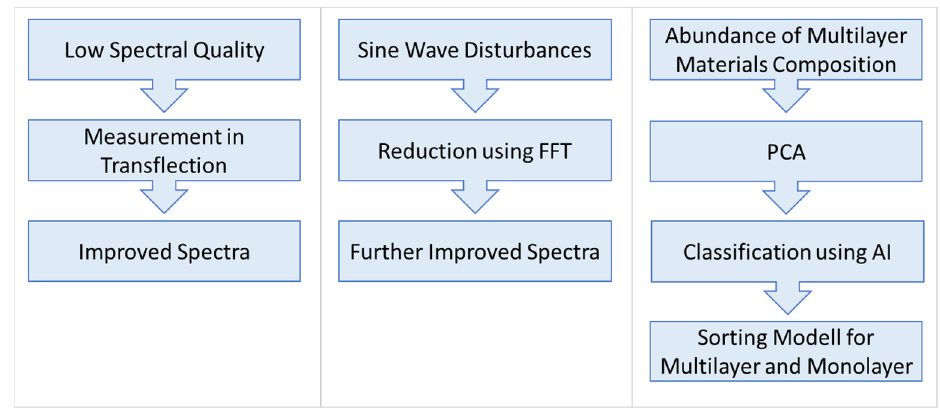
Figure 11. Summary of encountered problems when sorting films and the applied solutions.